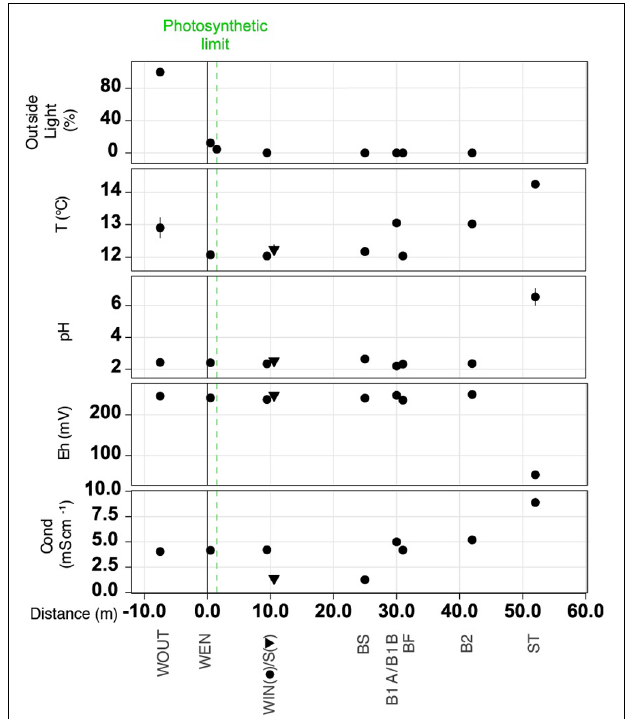
FIGURE 2 | Spatial variation of geochemical variables [conductivity, Cond.; redox potential, Eh; pH; T, ◦ C; and outside light (%)] of the AMD samples across collection sites. Symbols (dots or triangles) and vertical error bars represent the mean of the three measurements at each sampling location and their corresponding standard errors,